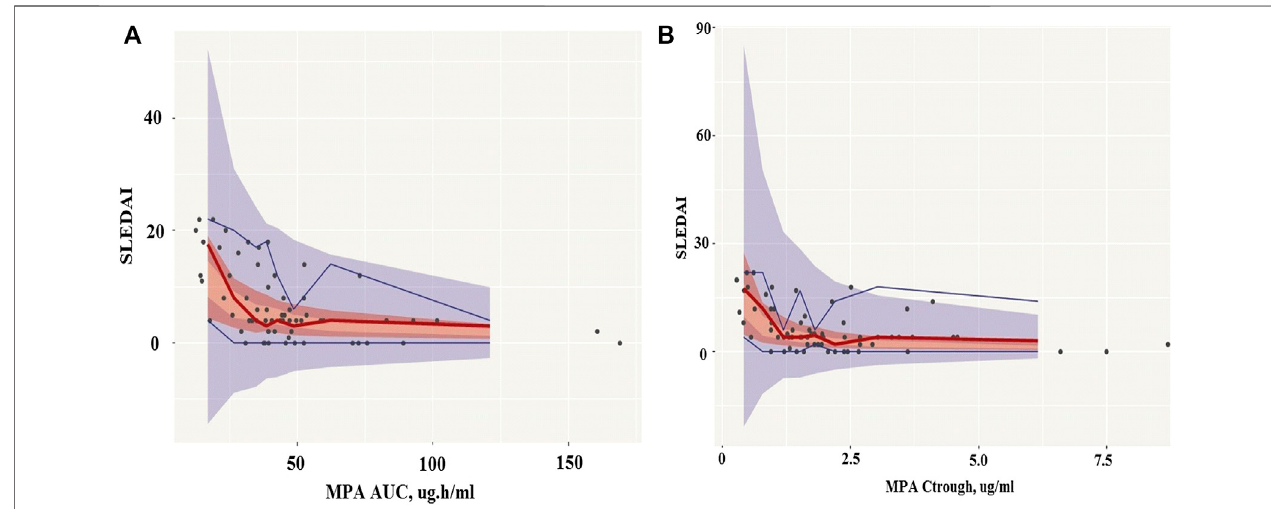
FIGURE 7 | Visual predictive check (VPC) of mycophenolic acid models. (A) , The AUC-response model. (B) , The C trough -response model. Circles represent the observed blood concentrations; Lines represent the median, 5 and 95th percentiles of simulations (n (cid:2) 1,000).